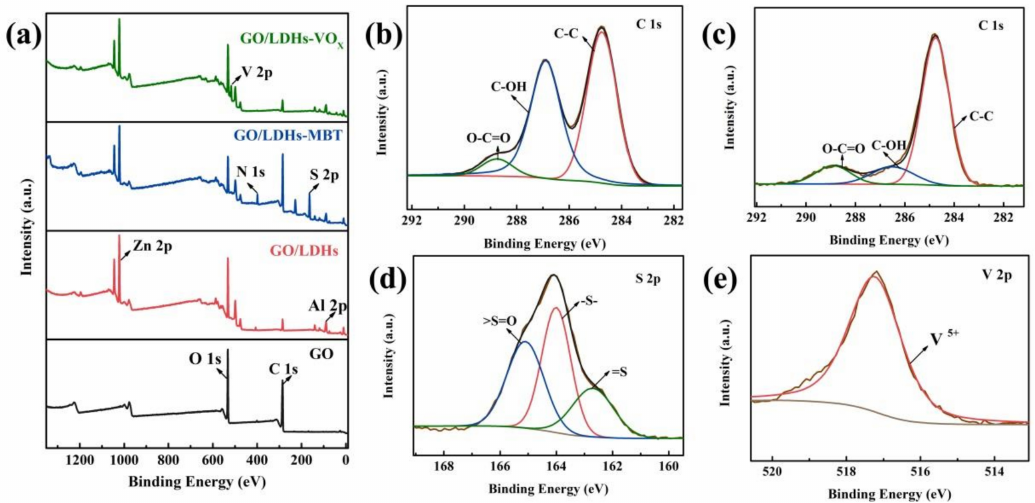
Figure 4. ( a ) X-ray photoelectron spectroscopy (XPS) spectra of GO, GO/LDHs, GO/LDHs-MBT, and GO/LDHs-VO x ; ( b ) C 1 s XPS spectrum of GO and ( c ) GO/LDHs; ( d ) S 2 p XPS spectrum of GO/LDHs-MBT; and ( e ) V 2 p XPS spectrum of GO/LDHs-VO x